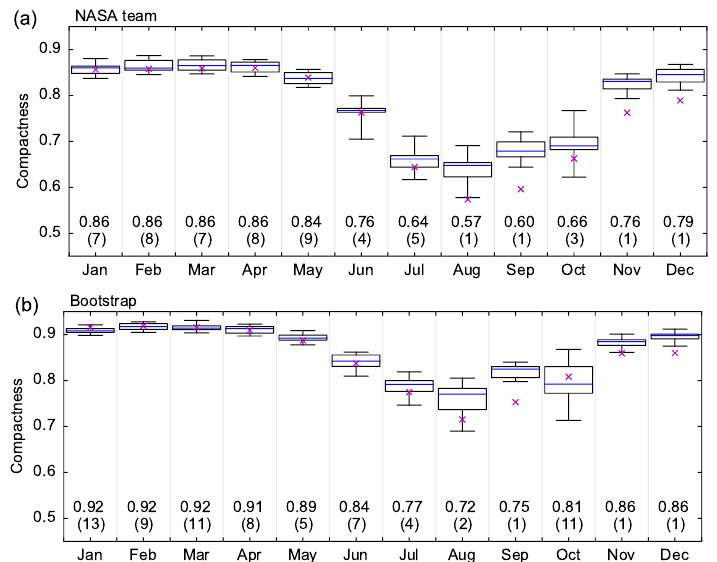
Figure 4. Arctic sea ice compactness from 2000 to 2015, calculated as the monthly Arctic sea ice area (SIA) over sea ice extent (SIE), using the NASA Team (a) and Bootstrap (b) data. The magenta crosses and the number above the brackets denote the monthly 2016 compactness (SIA / SIE), while the number in brackets gives the rank of the 2016 compactness across the 2000–2016 period (1 represents a record low in